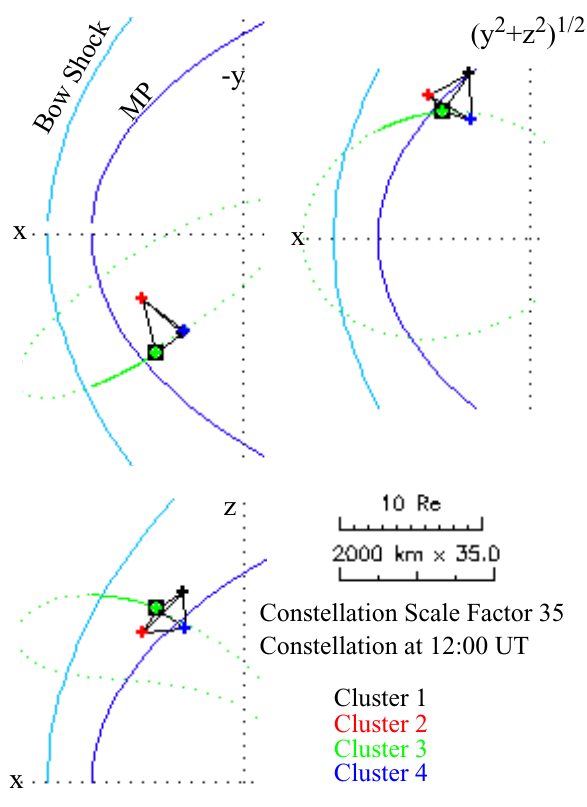
Figure 1. Cluster orbits at the high-latitude dusk flank MP. Fig. 1. Cluster orbits at the high-latitude dusk flank MP. The space- The spacecraft separation is ~650 km. Spacecraft 1,2, and 3 craft separation is ∼ 650km. Spacecraft 1, 2, and 3 are roughly in are roughly in the same plane tangential to the MP. the same plane tangential to the MP. Spacecraft 4 is earthward of Spacecraft 4 is earthward than the other 3. Figure adapted the other 3 spacecraft. Figure adapted from from CSDSWEB.